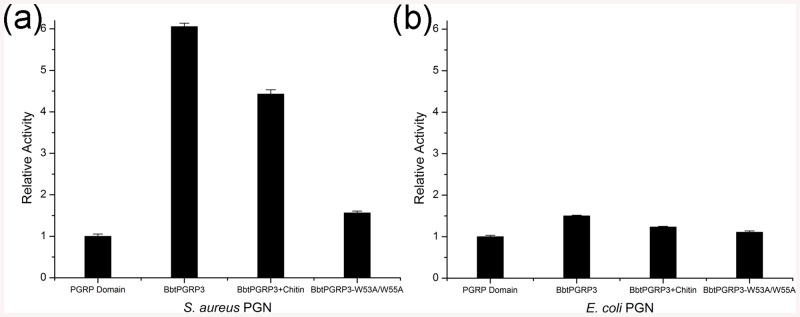
Cooperation of the N- and C-terminal domains of BbtPGRP3.Reactions containing RBB-labeled (a) S. aureus PGNs or (b) E. coli PGNs were incubated with 50 nM PGRP domain, BbtPGRP3 in the absence or presence of chitin and BbtPGRP3-W53A/W55A, respectively. Undigested PGNs were pelleted by centrifugation and the absorbance of the supernatants at 595 nm were determined. Results of activity are expressed as the folds to that of individual PGRP domain. The values are expressed as mean values ± SD of three independent experiments.